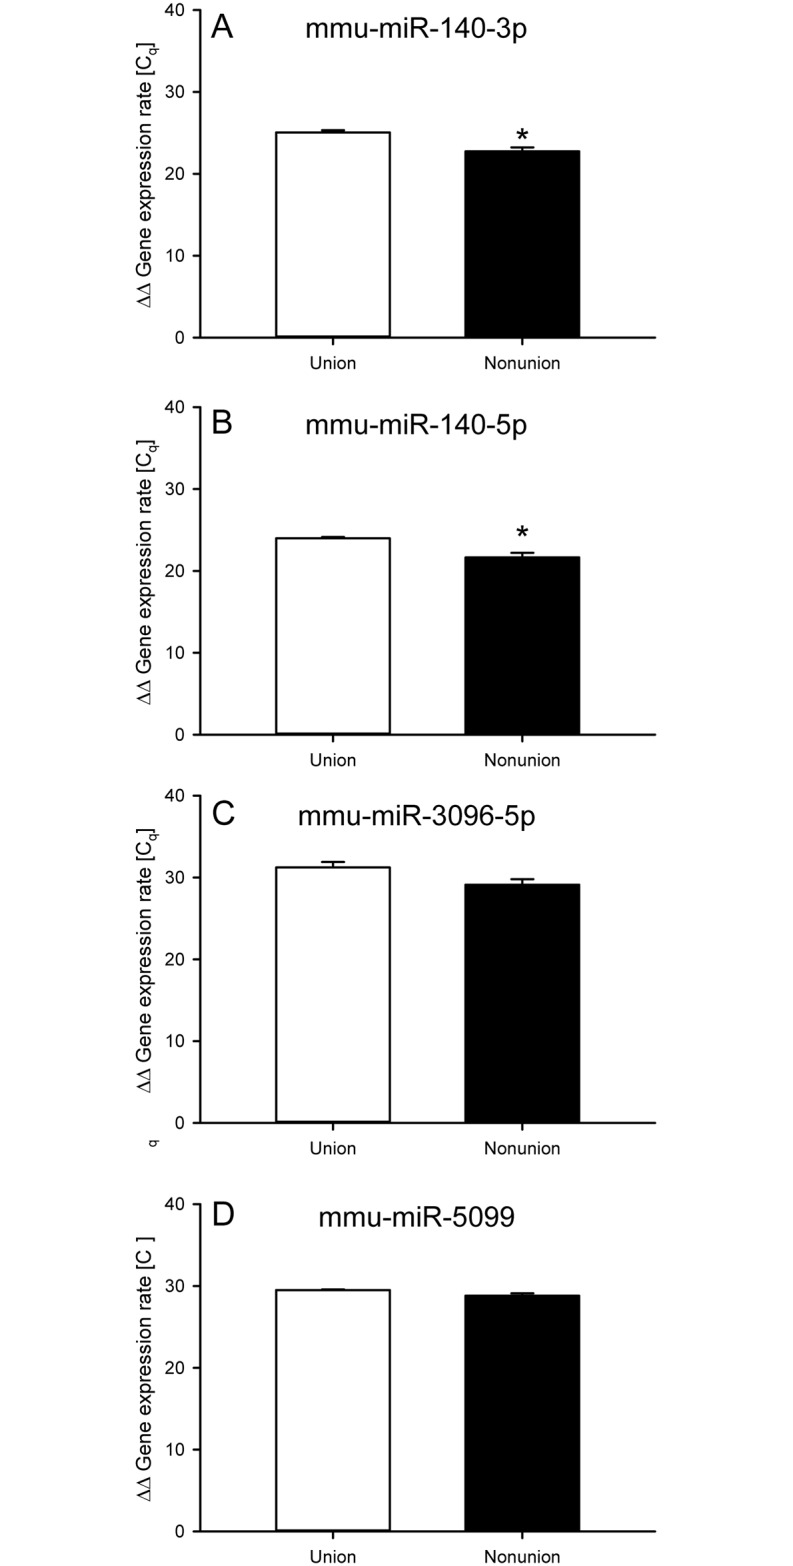
qrt-PCR analyses of callus tissue confirms different expression levels for miR-140-3p and miR-140-5p.A-D: ΔΔ Gene expression rate after qrt-PCR analyses of mmu-miR-140-3p (A), mmu-miR-140-5p (B), mmu-miR-3096-5p (C) and mmu-miR-5099 (D) at 7 days after surgery within the callus of the Union group (white bars; n = 4) and the Nonunion group (black bars; n = 4). Mean ± SEM; *p <0.05 vs. Union.